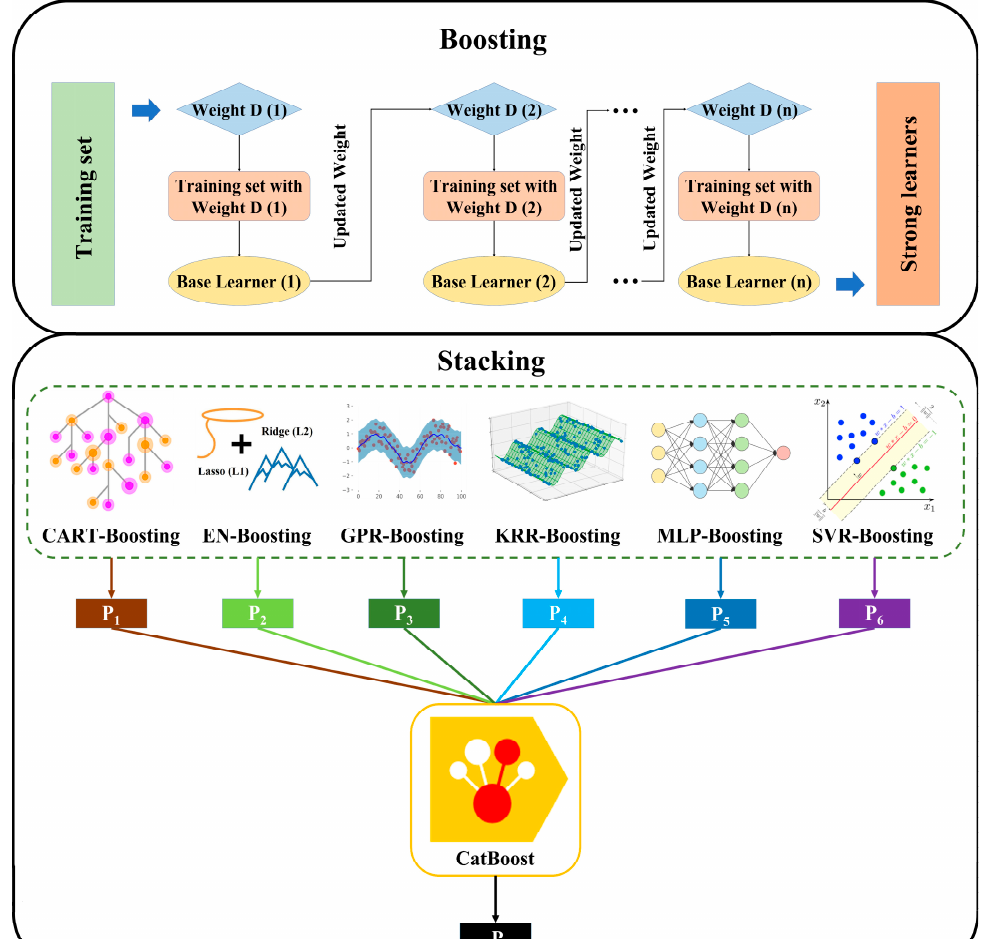
Figure 4. Flow chart of Stacked–Boosting ensemble learning model. To maximize the use of limited samples and improve the prediction accuracy